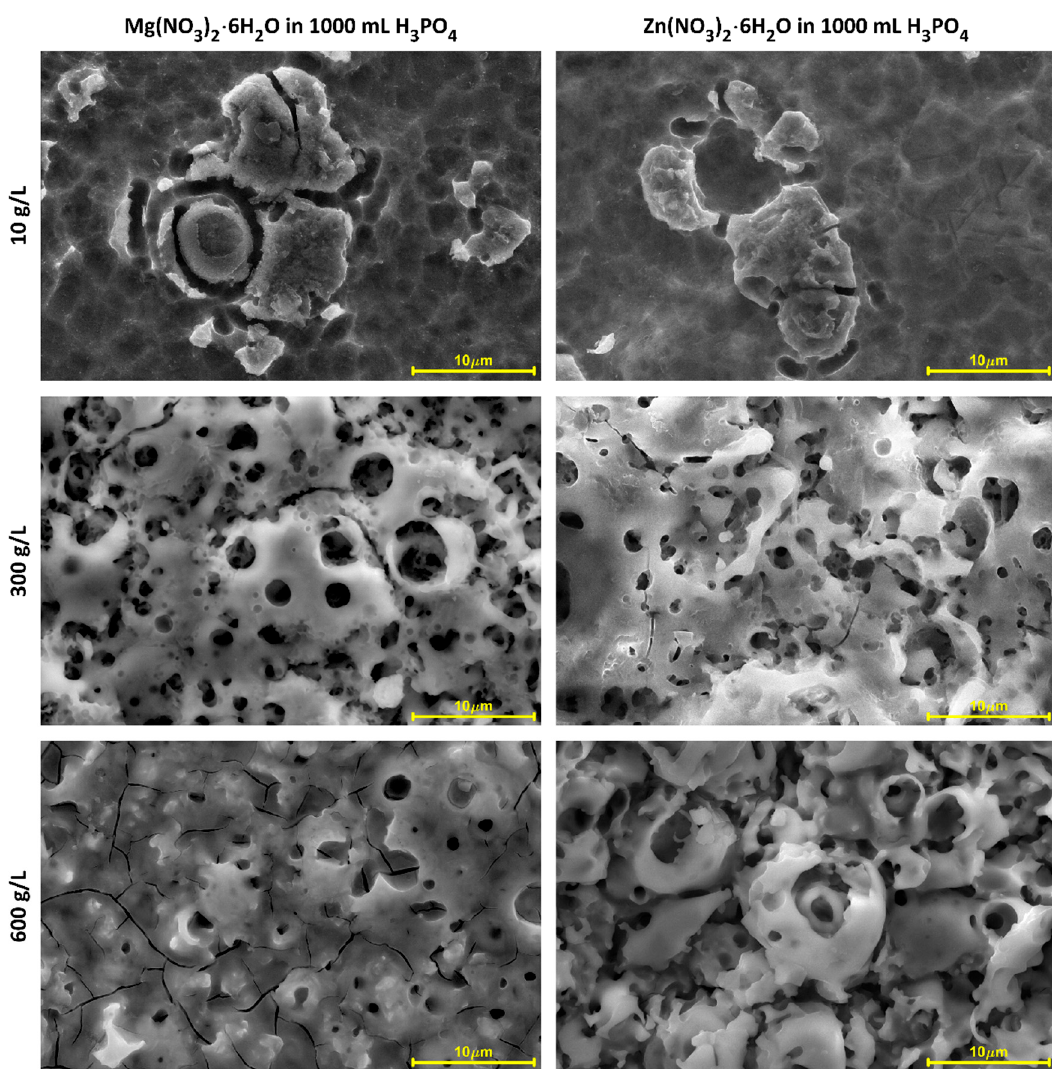
Figure 2. SEM micrographs of samples surfaces after PEO processing obtained in electrolytes composed of Mg(NO 3 ) 2 ·6H 2 O and Zn(NO 3 ) 2 ·6H 2 O in H 3 PO 4 in three concentrations 10 g/L, 300 g/L, and 600 g/L, at a voltage of 450 ± 46 V, with a pulsation frequency of 300 Hz. Magnification 10,000 times.